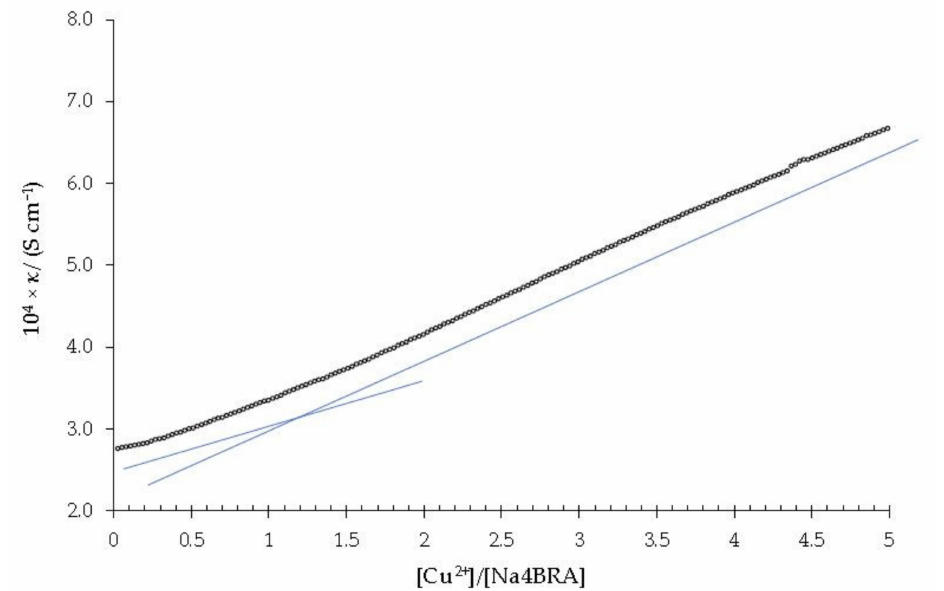
Figure 3. Specific conductivity versus the [Cu 2+ ]/[Na 4 BRA] ratio. The solid blue lines (which are represented displaced parallel for better visualization) are shown as a visual aid to indicate the cut-off point that relates to the change in the slope of the specific conductivity with respect to the stoichiometry of the